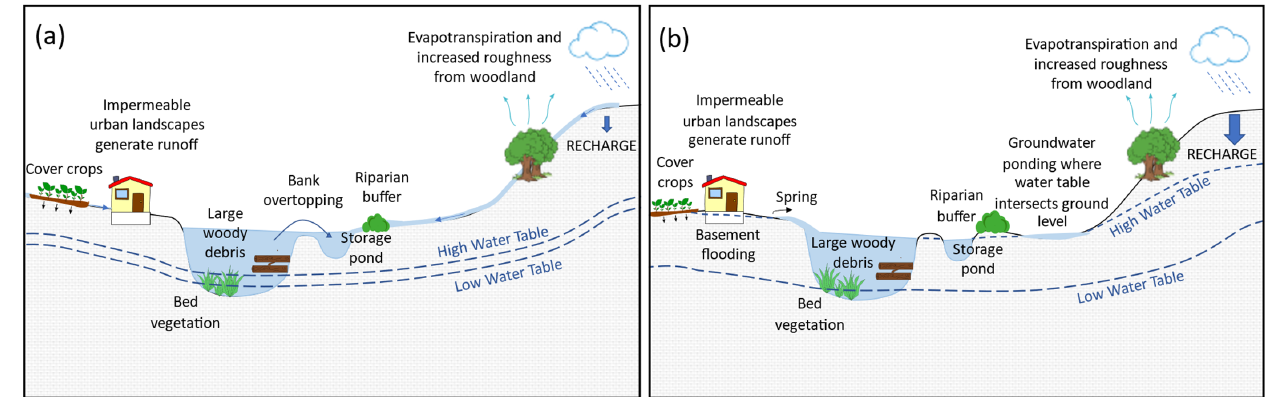
Figure 1. The processes of flooding in impermeable upland catchments ( a ) and in permeable chalk catchments ( b ) along with common NFM interventions to demonstrate how groundwater dominance in flood production may impact the efficacy of NFM.